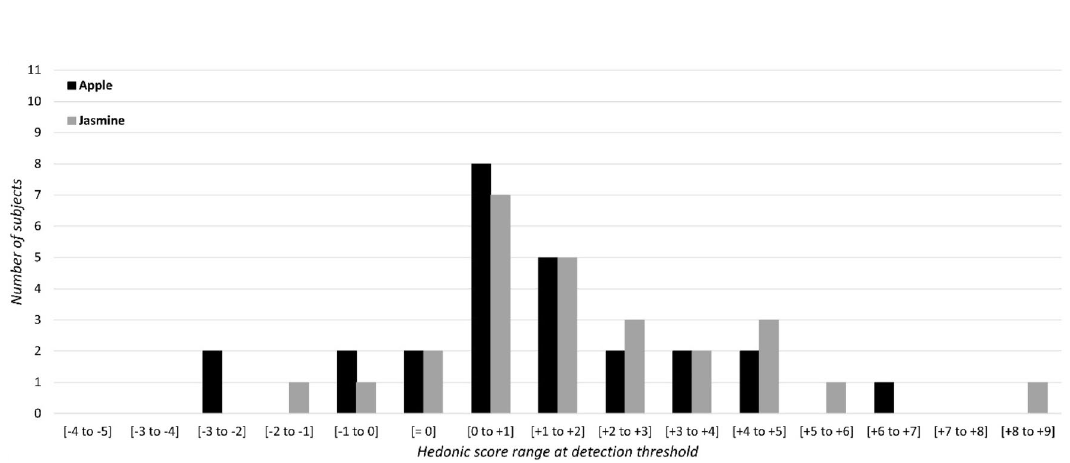
Figure 2. Hedonic scores at IDT for pleasant odors: number of subjects for each score range (e.g., [− 2 to − 1] means that odor hedonic rating is comprised between − 2 and − 1). OHR were assessed on a visual analog scale ranging from 0 to + 9 for the pleasant polarity and from 0 to − 9 for the unpleasant polarity.